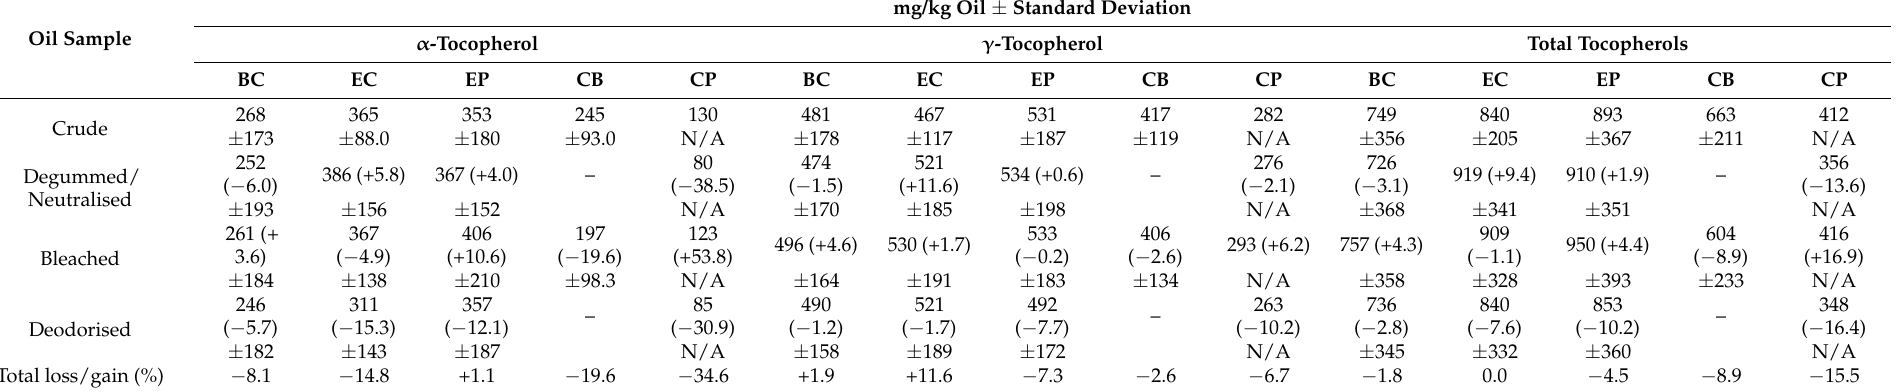
Table 4. Concentration of individual and total tocopherols (mg/kg oil ± standard deviation). Cumulative percentage gain/loss relative to the previous process is represented in brackets under concentrations for refining methods. Total loss/gain is reported in the bottom row and represents the total loss or gain of bioactive compound from crude oil to the deodorisation step.